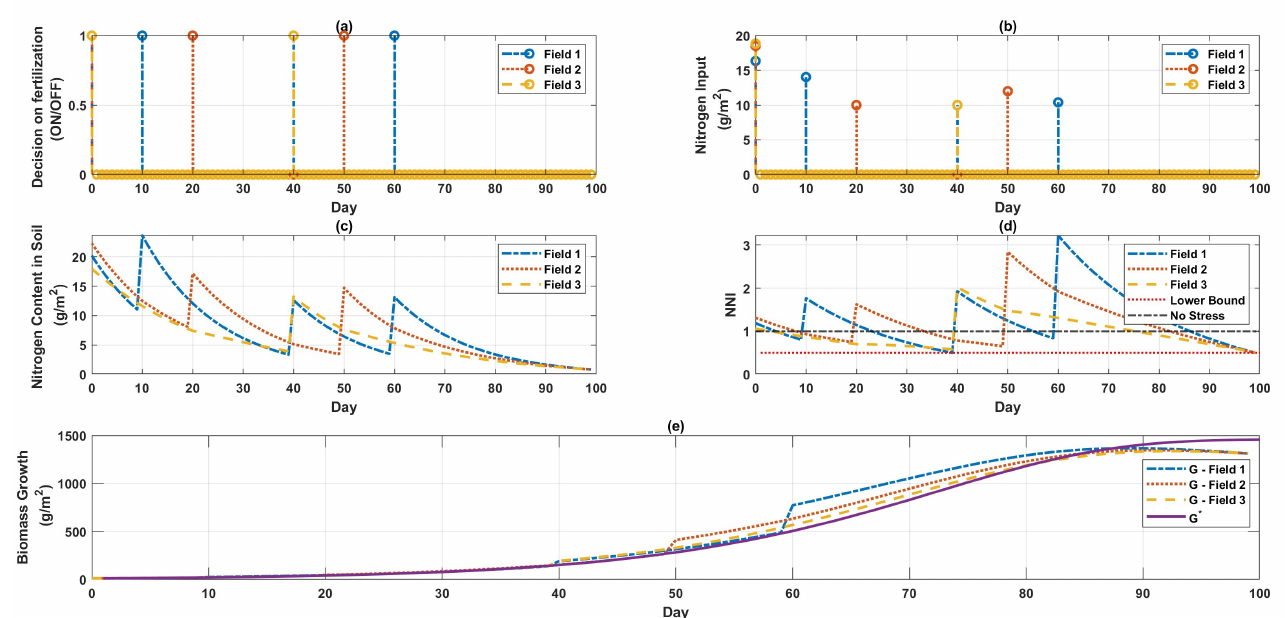
Figure 4. Maximum growth considering the cost of labor and resources for multiple fields. ( a ) Indi- cates the days when fertilizer delivery is ON for the three fields, ( b ) displays how much fertilizer is required on these days in the three fields, ( c ) represents the nitrogen concentration of the soil within the three fields, ( d ) the NNI level, and ( e ) the progressive development of the biomass in the three